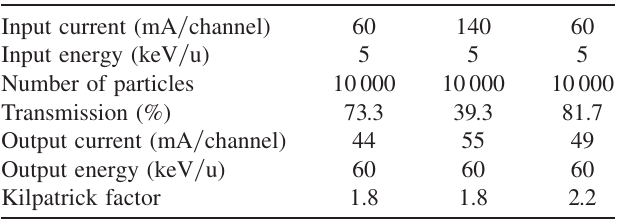
TABLE II. Summary of the PARMTEQM simulation parameters for an optimized cell